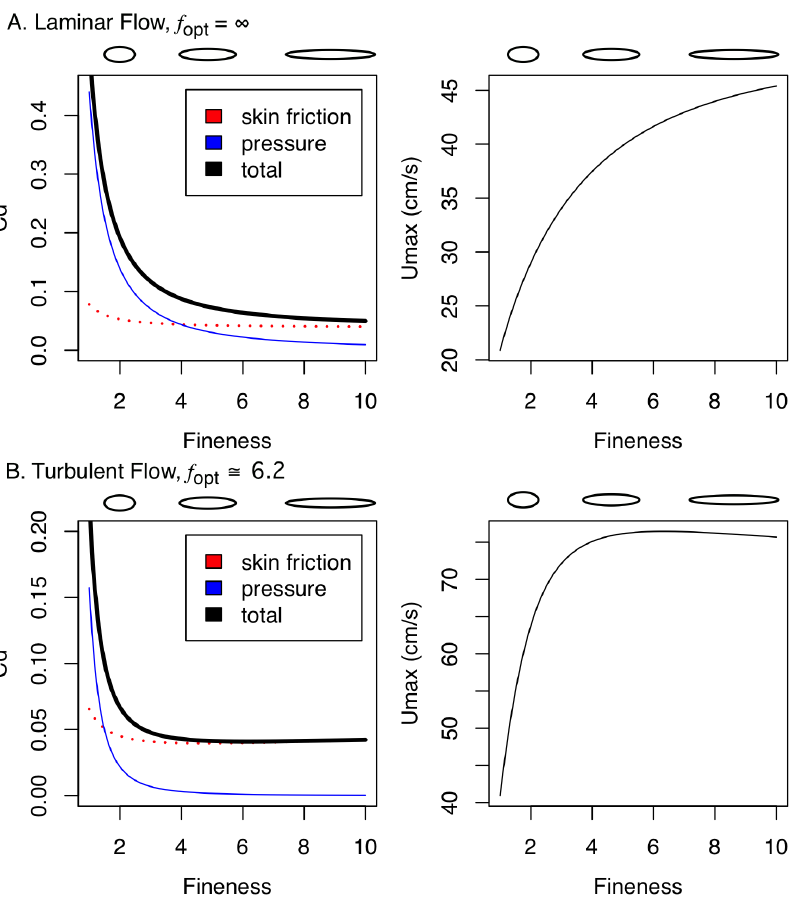
Figure 2. Performance as a function of fineness for rigid bodies of revolution. C D ( f ) (left panel) and modeled maximum-prolonged swimming speed (right panel) for laminar (A) and lower-end of turbulent (transitional) (B) flow. Drag coefficients are standardized using ( Vol ) 2/3 as the reference area and computed for bodies of equal volume and speed, but differing Reynold’s number ( Re ). Total (black line), skin friction (dotted red line) and pressure (thin blue line) components are illustrated. The elliptical figures above the plot are representative midline sections for finenesses of 2, 5, and 10 to show the relative length and depth of bodies of differing fineness but equal volume. The scale of the ordinate differs between (A) and (B) to emphasize the shape of the curve within each plot.